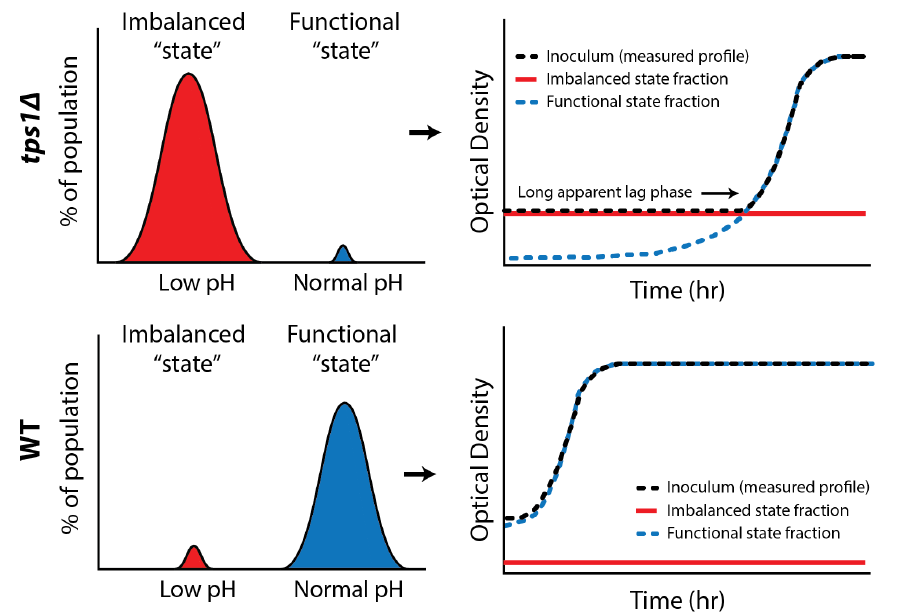
FIGURE 1: Bistability in glycolysis leads to two distinct subpopula- tions. Intracellular pH measure- ments reveal such metabolic subpopulations, with sizes that correspond to observed growth